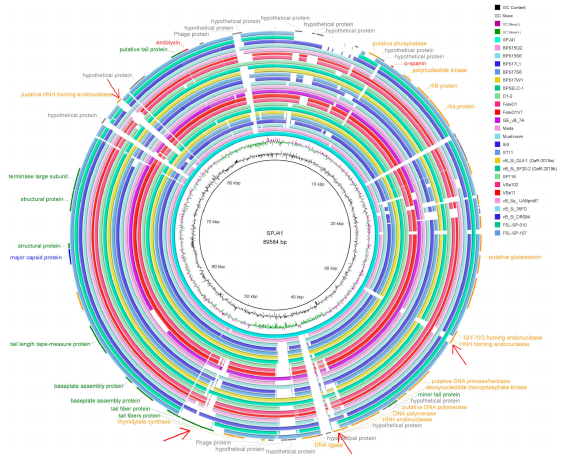
Figure 4. The phage comparative genome circle map of 25 strains of the genus Felixounavirus . From the inner circle to the outer circle are GC content, GC skew, reference genome SPJ41, and the phages of the genus Felixounavirus . The outermost circle is the functional annotation: red, cell lysis module; gray, hypothetical protein; orange, DNA replication/modification/regulation; green, phage structure; blue, DNA packaging; and purple, phage–host interactions. The red arrows are functional protein difference